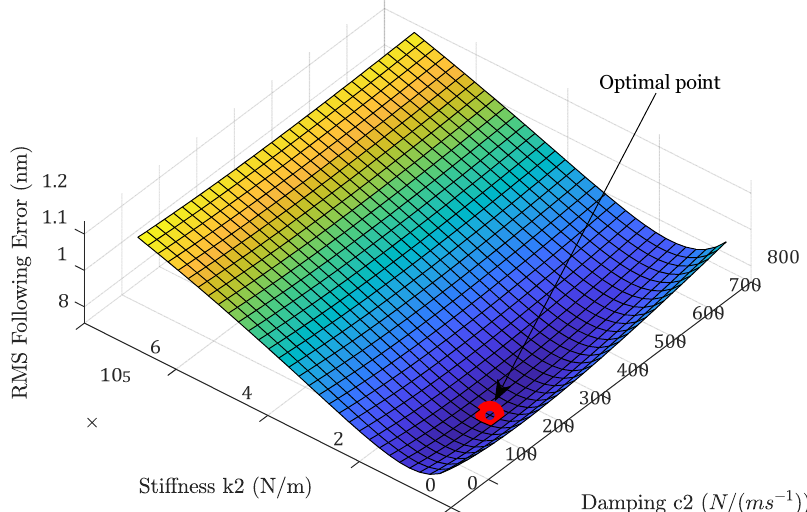
Figure 14. Optimal bearing stiffness and damping under the current disturbance situations.